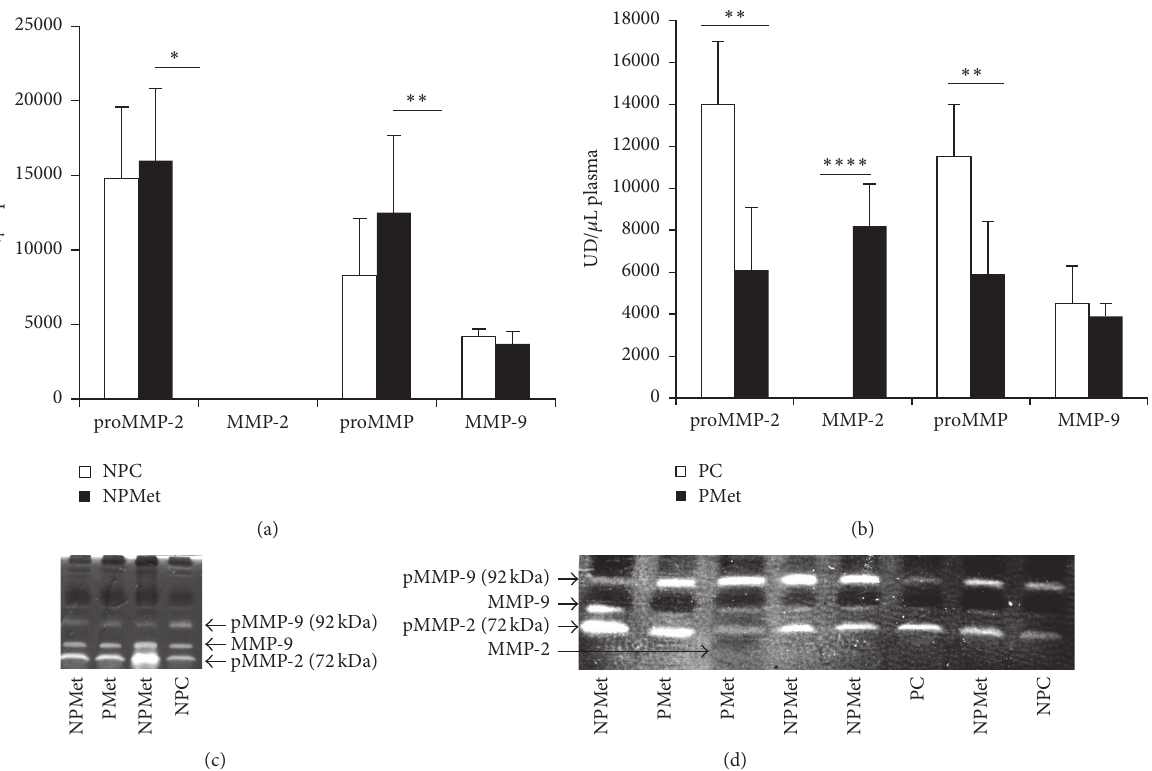
Figure 2: Plasma MMP activities of the 4 female rabbit groups. NP: nonpregnant control, NPMet: nonpregnant with Met, PC: pregnant control, and PMet: pregnant with Met. Comparison of NPMet versus NPC and PMet versus PC ( ∗ 𝑝 < 0.05 , ∗∗ 𝑝 < 0.01 , and ∗∗∗∗ 𝑝 < 0.0001